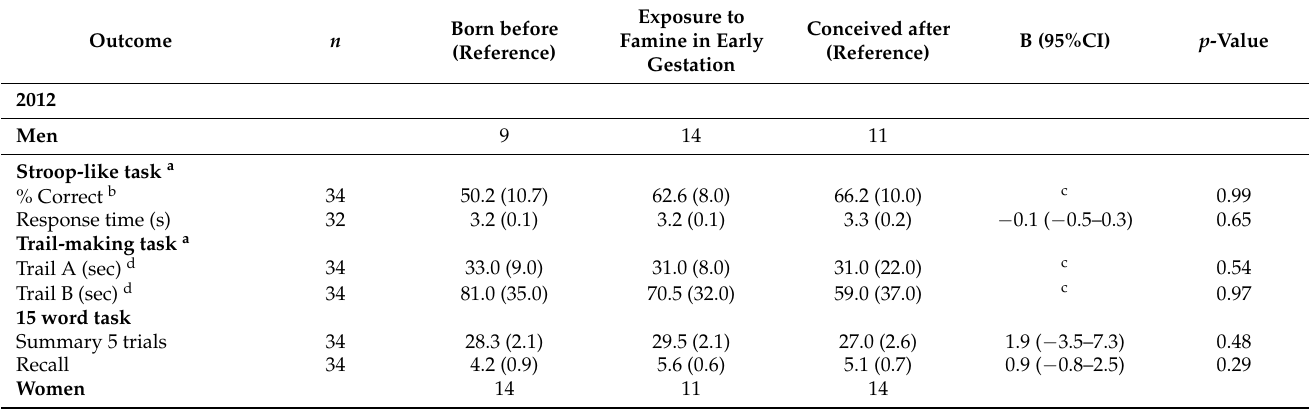
Table 3. Associations between prenatal exposure to famine and cognitive outcomes compared with individuals born before or conceived after the famine around age 68 (2012) and 74 (2019) by